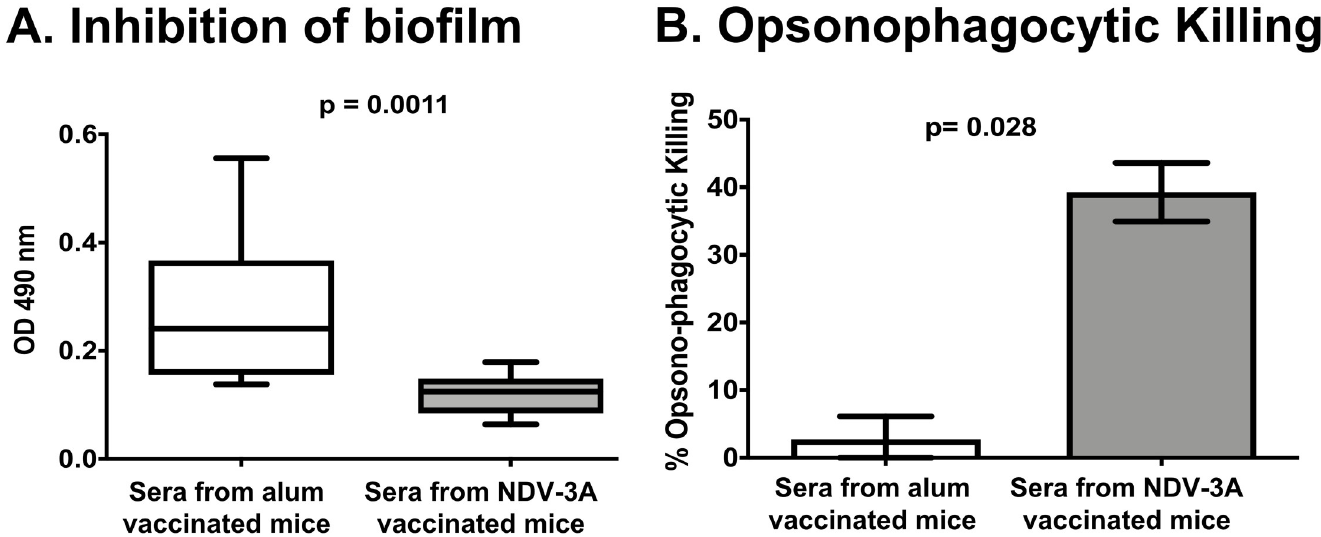
Fig 4. Anti-Als3p sera inhibit C . auris biofilm formation and augment OPK of the yeast by murine macrophages. (A) C . auris biofilms were evaluated in 96-well plates in presence of serum from NDV-3A- or alum-vaccinated mice. The serum from NDV-3A-vaccinated mice significantly reduced C . auris biofilm formation compared to alum control mice (n = 10). (B) OPK of C . auris by macrophages was evaluated in presence of serum from NDV-3A- or alum-vaccinated mice. The serum from NDV-3A-vaccinated mice significantly enhanced yeast OPK compared to alum group (n = 4). Results are presented relative to macrophage killing of C . auris without any added serum. Statistical significance was determined by Mann-Whitney Test. The p values < 0.05 was considered significant.